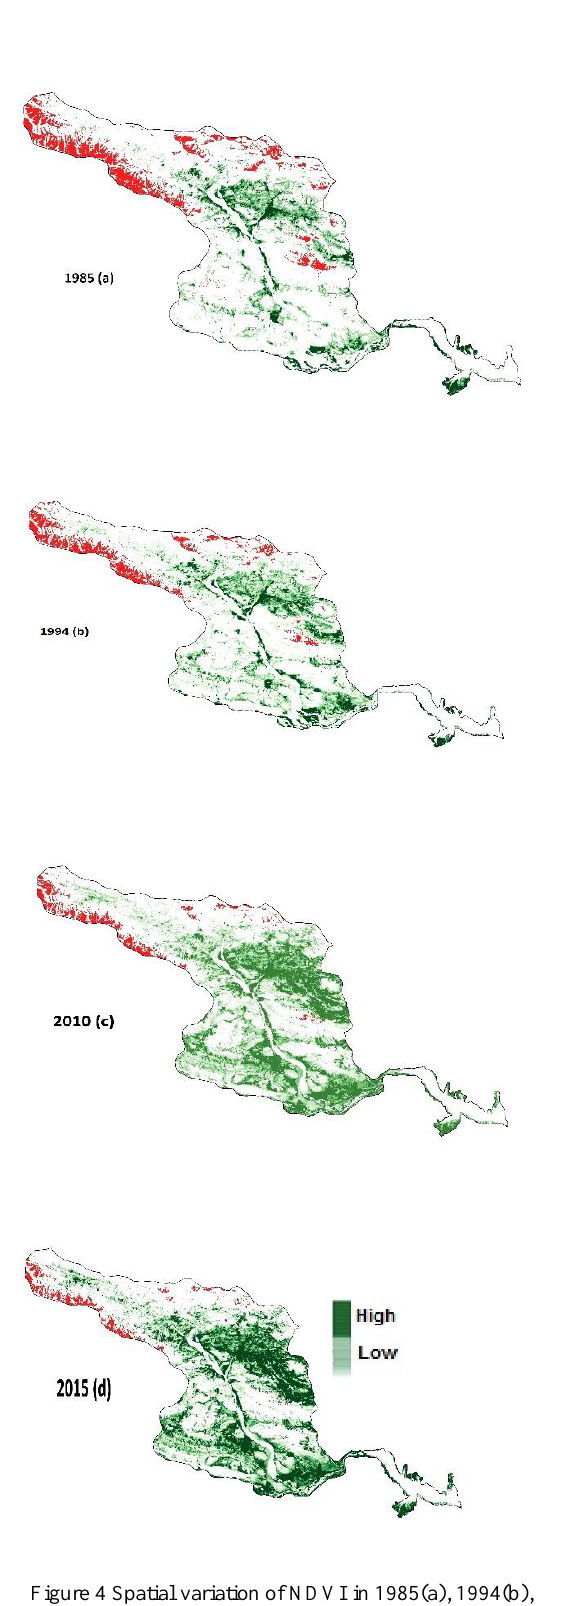
Figure 4 Spatial variation of NDVI in 1985(a), 1994(b),